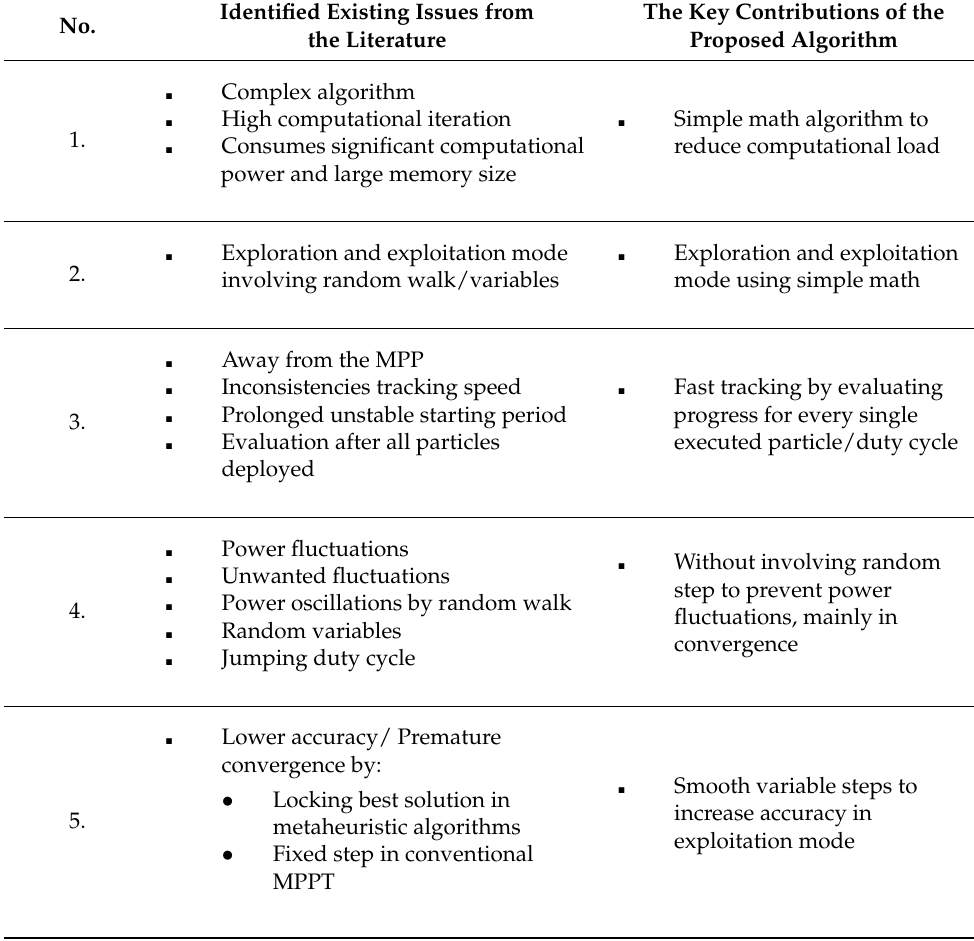
Table 1. Comparison between issues and key